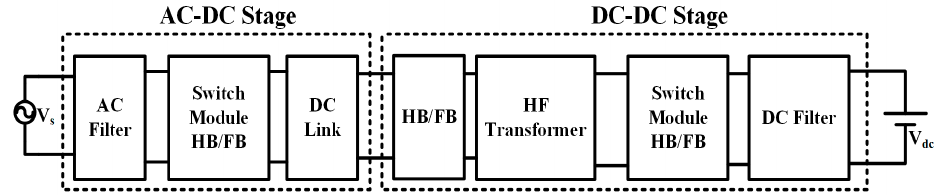
Figure 58. Low frequency AC-DC-High frequency AC-DC converter, also called two-stage converter. Adapted from [113]. Table 24. Converters with EV application displaying their key features and uses in EVs. Configuration Buck converter